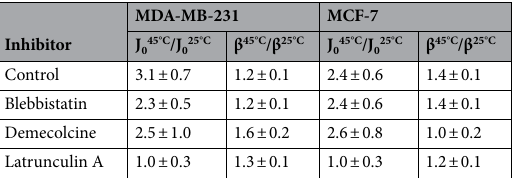
Table 1. Relative changes of creep compliance J 0 and fluidity β from 25 to 45 °C for MDA-MB-231 and MCF-7 cells after treatment with different inhibitors.